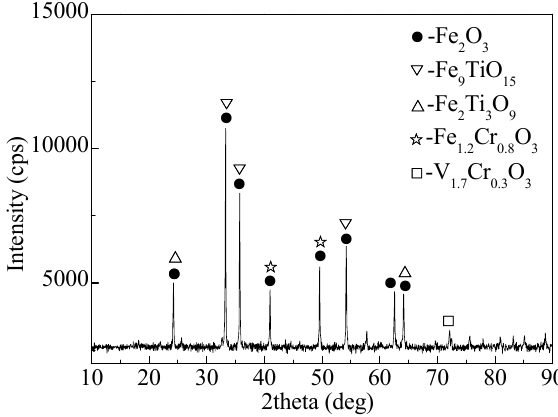
Figure 8. XRD analysis of the oxidized HCVTM pellets.